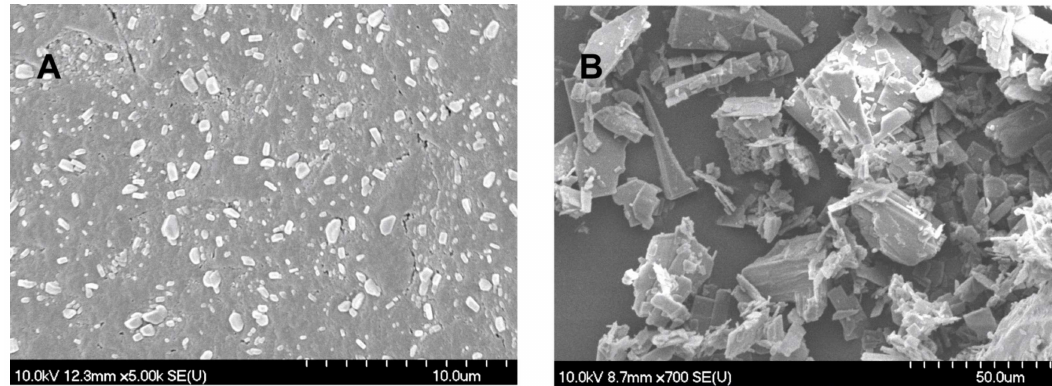
Figure 1. SEM images of nanonized MEL ( A ) and MELP ( B ).